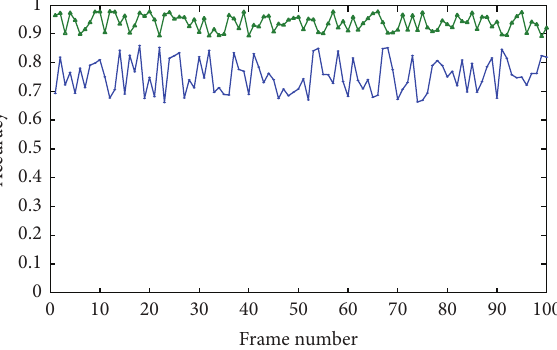
Figure 10: Algorithms’ accuracy relating two different